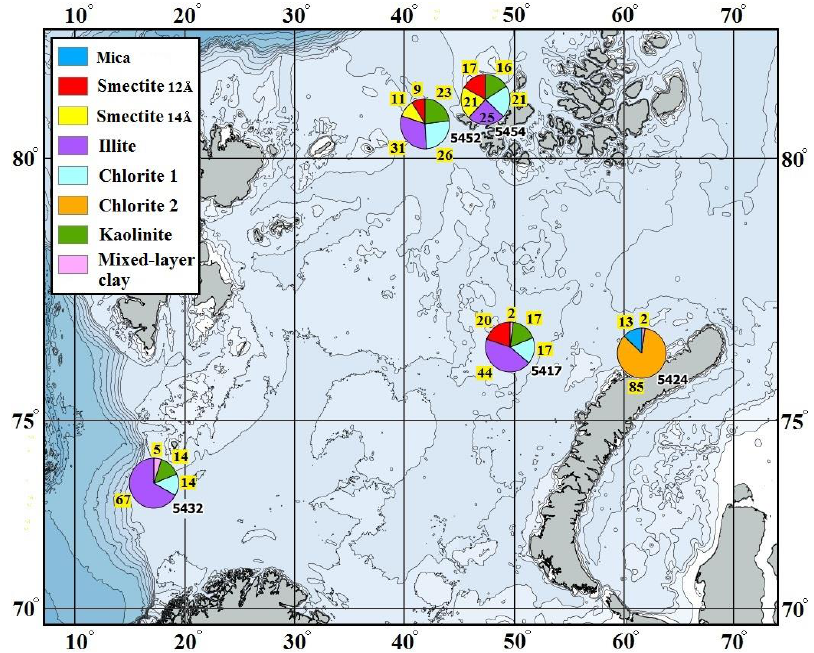
Figure 21. Diversity of clay mineral in the surface bottom sediments of the Barents Sea, in accordance with the cores studied: 5432, 5452, 5454, 5417, and 5424. Values around the circle diagrams indicate percentage of minerals.